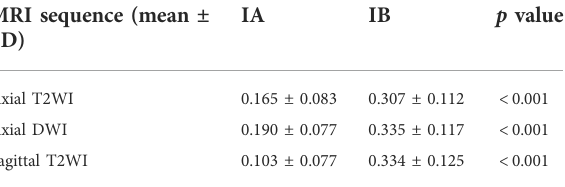
TABLE 5 Mean TURs of all patients on three different MRI sequence